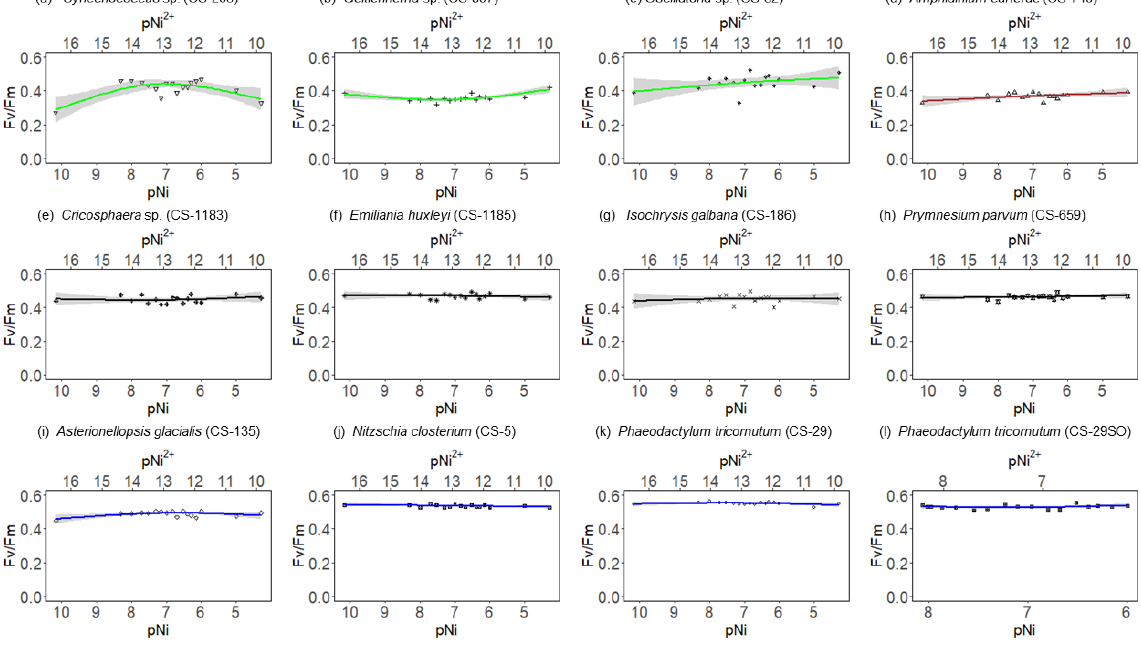
Figure 3. F v /F m results of phytoplankton cultures. p Ni and p Ni 2 + are the − log 10 transformed values of the total dissolved and free Ni 2 + concentrations (Eq. 1). A smaller value represents a higher concentration. Plots (a) – (c) are cyanobacteria; plot (d) is a dinoflagellate; plots (e) – (h) are haptophytes; plots (i) – (l) are diatoms. Plots (a) – (k) were from strains growing in Aquil media, while plot (l) shows results for P. tricornutum growing in natural seawater media. Solid lines represent the smooth terms produced from GAMs using the growth rate data and p Ni concentrations. Shading indicates the 95% confidence interval. P values < 0.05 indicate that the smooth term is significantly different from a straight line. P values < 0.05 are indicated by ∗ , and P values < 0.01 are indicated by ∗∗